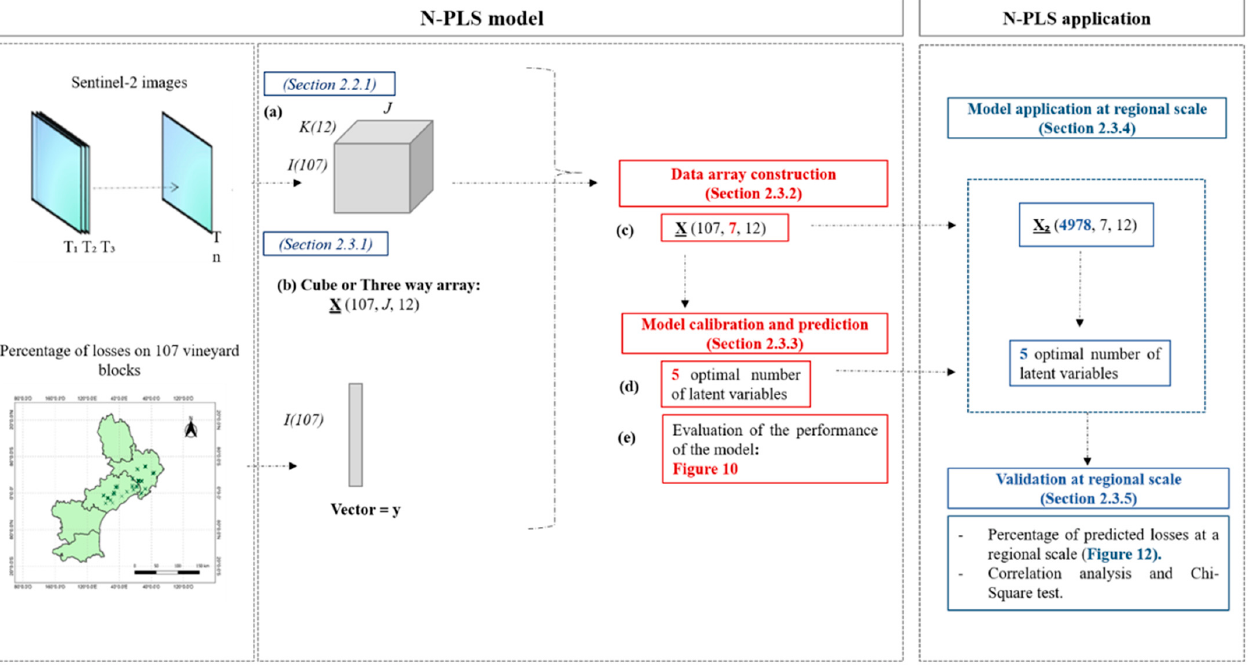
Figure 7. Workflow scheme of the calibration of the N-PLS model, the prediction evaluation and its application to 4978 vineyard blocks at the regional scale.